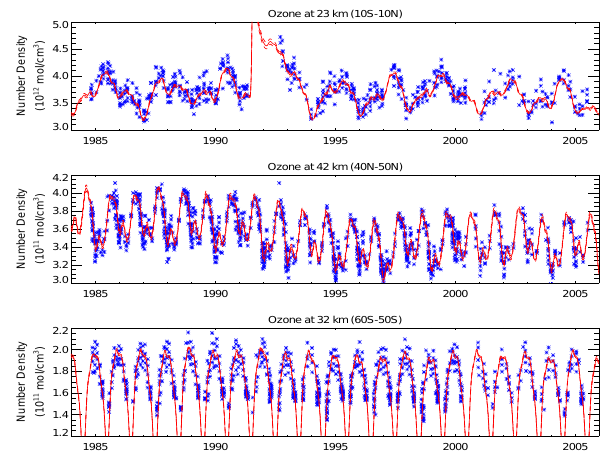
Figure 3. Some examples of the STS regression. Data within the stated latitude bin are shown in blue while a fit at the center of the bin is shown in red. The data shown have autocorrelation and diurnal variation removed for the purposes of plotting.